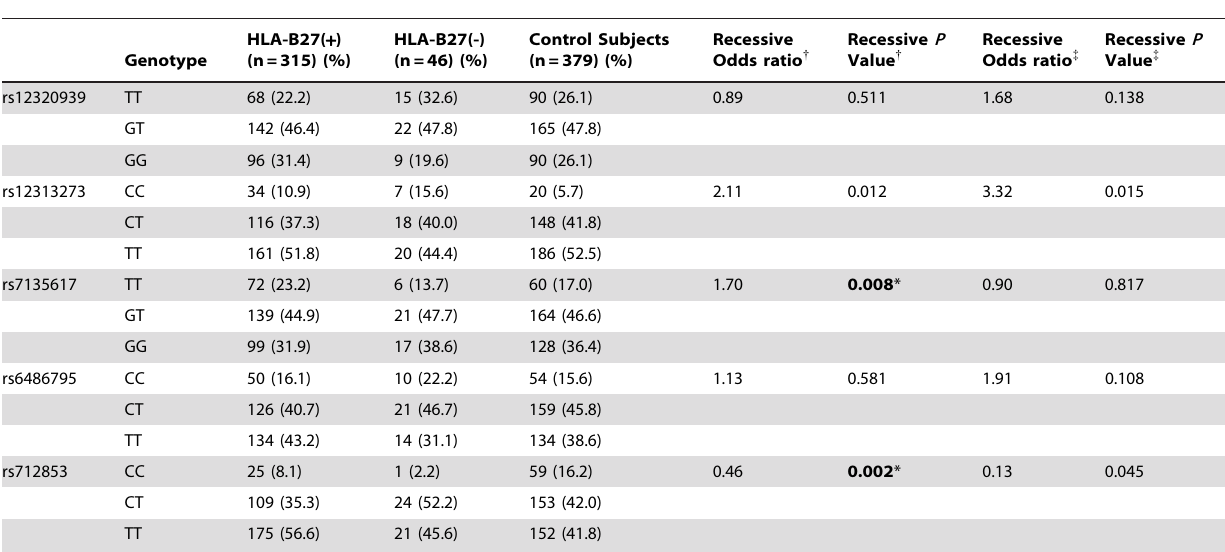
Table 2. Genotyping and allele frequency of ORAI1 tSNP in HLA-B27( + ) or HLA-B27(-) with ankylosing spondylitis (AS) and